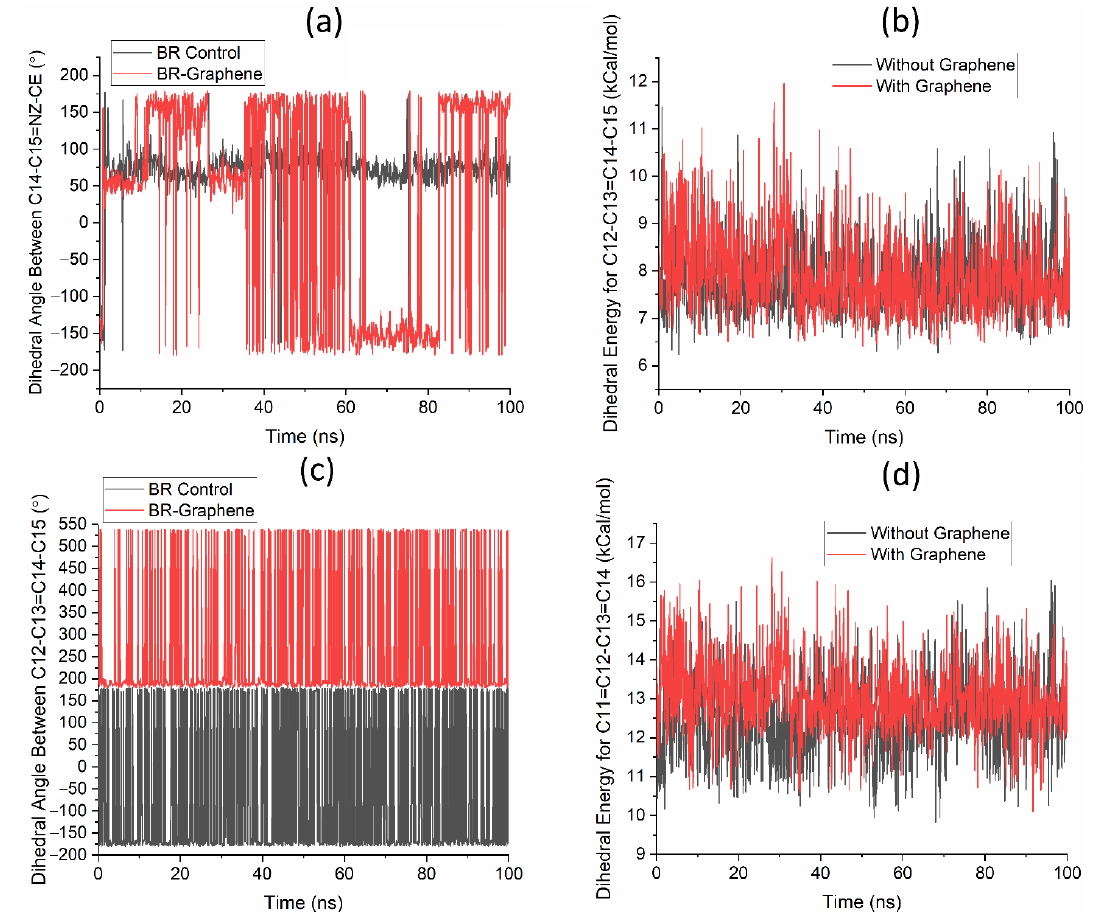
Figure 5. Analysis of Retinal Dihedral energies and angles: ( a ) Variation in the dihedral angle C14-C15 = NZ-CE between bR and retinal chromophore over a period of 100 ns; ( b ) Variation in dihedral energy for C12-C13 + C14-C15 dihedral within the retinal chromophore over a period of 100 ns; ( c ) Variation in the dihedral angle C12-C13 = C14-C15 within the retinal chromophore over a period of 100 ns (note the offset of 360 degrees for the bR–graphene plot to avoid overlap between the two plots in the presence and absence of graphene); ( d ) Dihedral energy changes for the dihedral C11 = C12-C13 = C14 over a period of 100 ns. All plots are compared for the presence and absence of graphene.